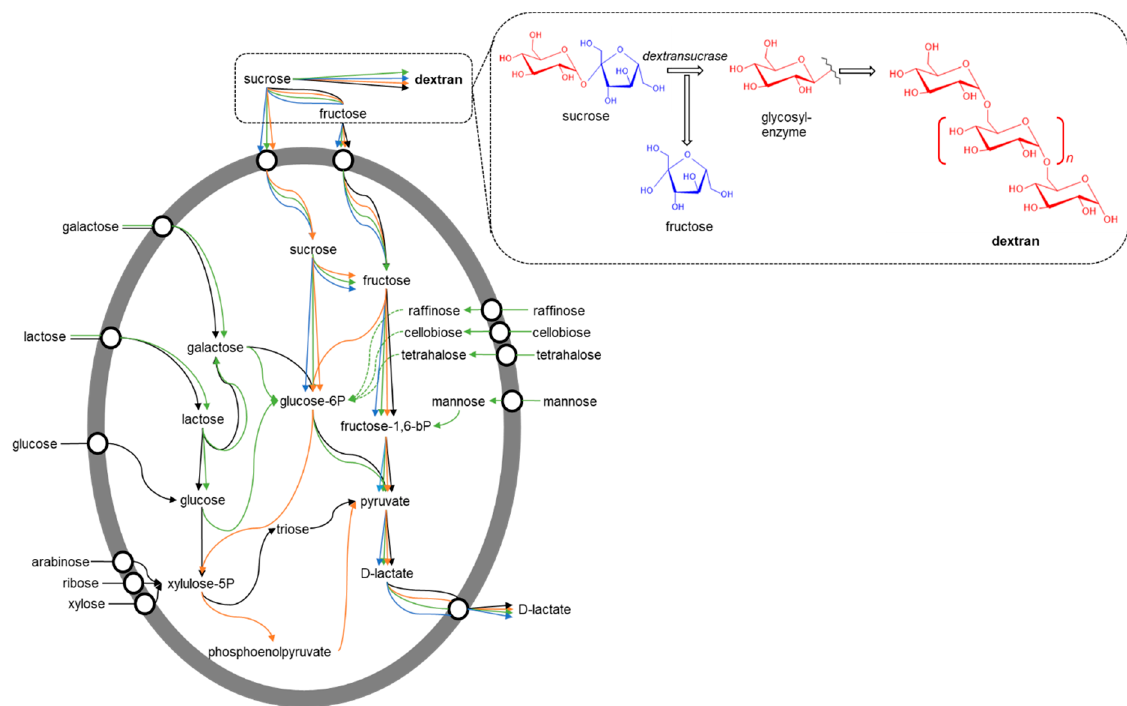
Figure 2. General carbohydrate pathways and dextran synthesis in lactic acid bacteria: Leuconostoc (black), Weissella (orange), Lactobacillus (blue), and Streptococcus (green). Adapted from [9–11,19,20].